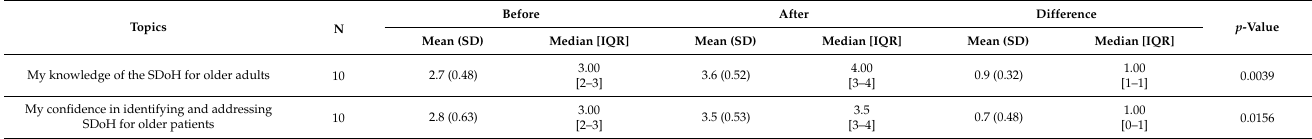
Table 3. Change in primary care staff knowledge and confidence 1 .